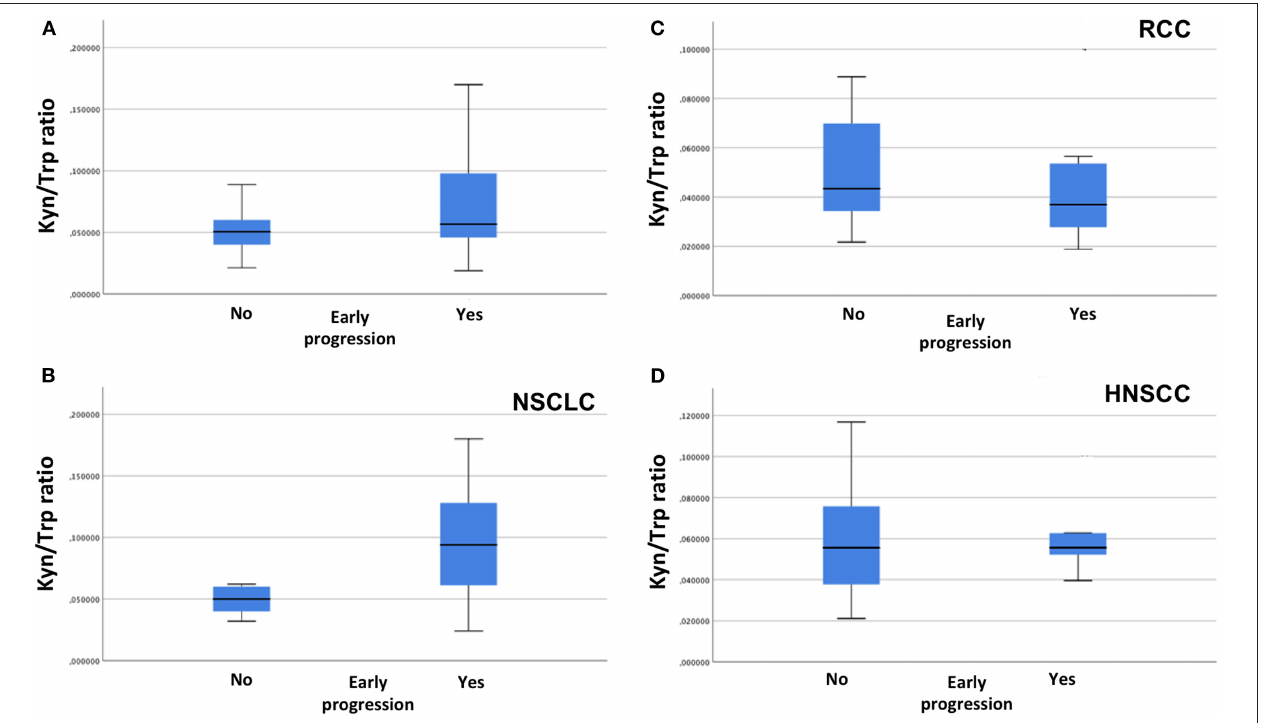
FIGURE 2 | Association between serum kyn/trp ratio and early progression in overall population (A) , in NSCLC group (B) , in RCC group (C) , and in HNSCC group (D) (Mann–Whitney U test). kyn, kynurenine; trp, tryptophan; NSCLC, non-small cell lung cancer; RCC, renal cell carcinoma; HNSCC, head and neck squamous cell carcinoma.